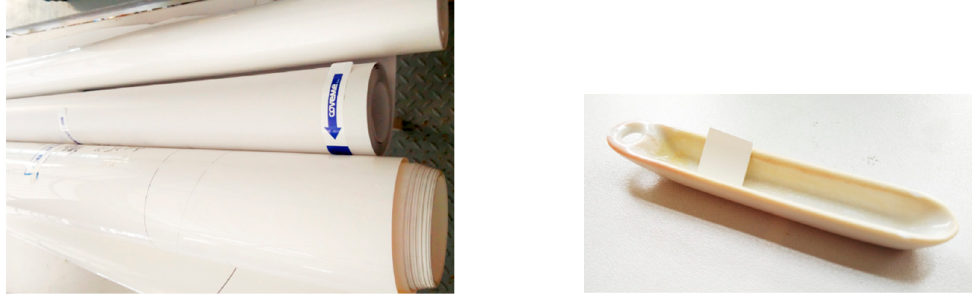
Figure 2. Production film ( left ); sample placed in a ceramic pan ( right ).